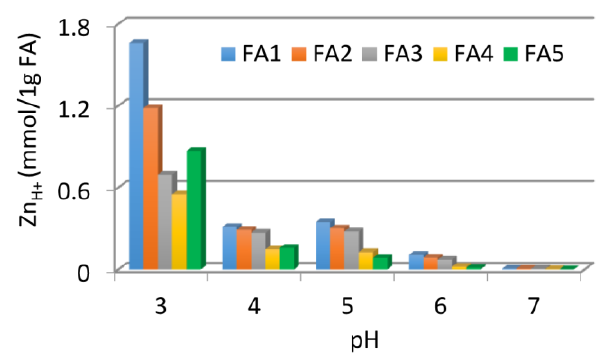
Figure 8. Efficiency of Zn(II) binding by FAs during exchange with protons as a function of pH. Figure 8. E ffi ciency of Zn(II) binding by FAs during exchange with protons as a function of